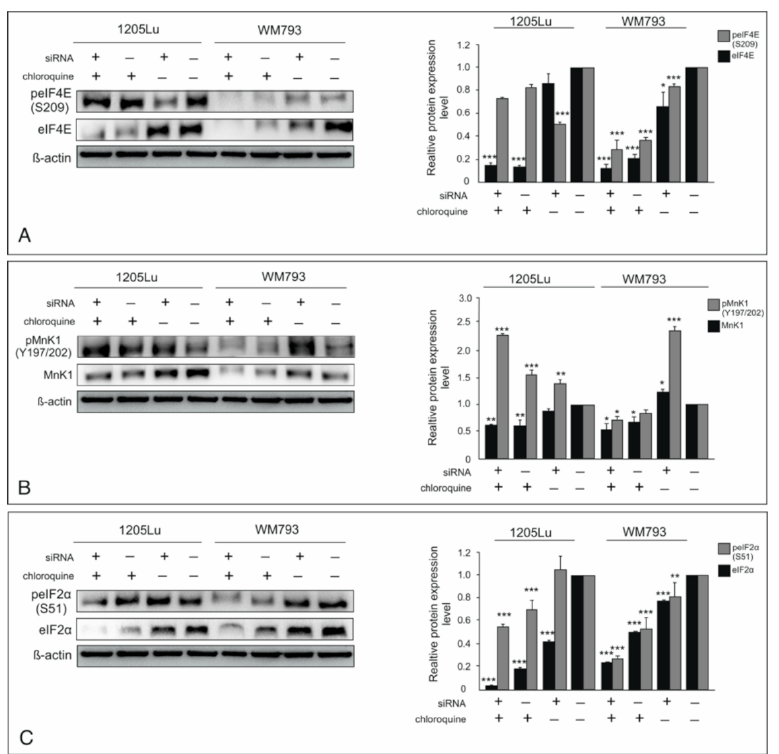
Figure 5. The inhibitory effect of ILK knock-down and CQ use on translation melanoma cells. “+” refers to siRNA ILK or chloroquine; “ − ” refers to silencer negative control cells. The expression of both phosphorylated and total proteins was determined by Western blotting and representative blots are displayed. The histograms are a quantitative representation of data after densitometry (mean ± SD) of three independent experiments. β -actin was used as a protein loading control. Asterisks indicate significant differences from control cells. Values are denoted as * p < 0.05, ** p < 0.01, and *** p < 0.001. ( A )—eukaryotic translation initiation factor 4F (eIF4E), ( B )—MNK1 kinase, ( C )— eukaryotic initiation factor eIF2 α